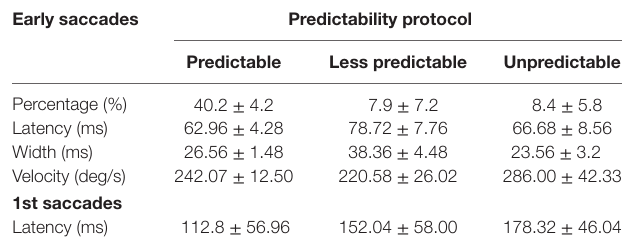
TaBle 1 | Mean of measurements for early and first saccades obtained with the different predictability groups.